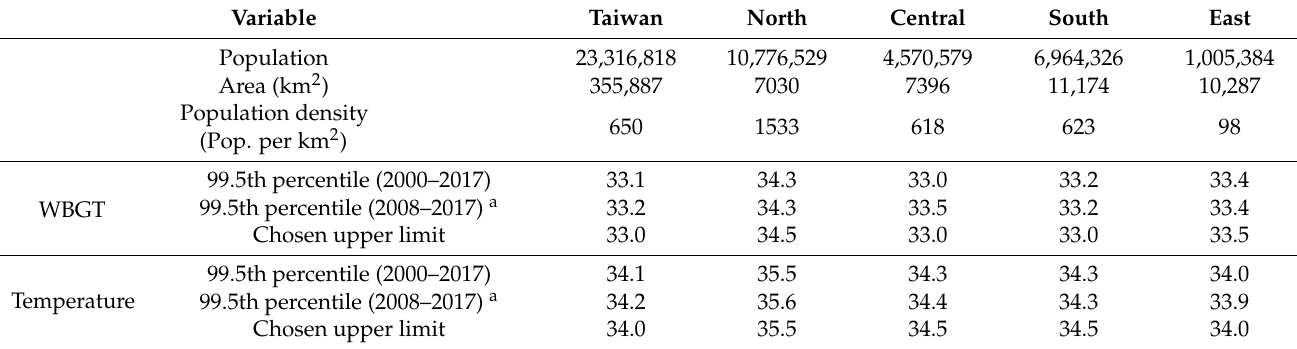
Table 1. Characteristics of Taiwan and sub-regions with 99.5th percentile of WBGT and temperature and chosen limits. Variable Taiwan North Central